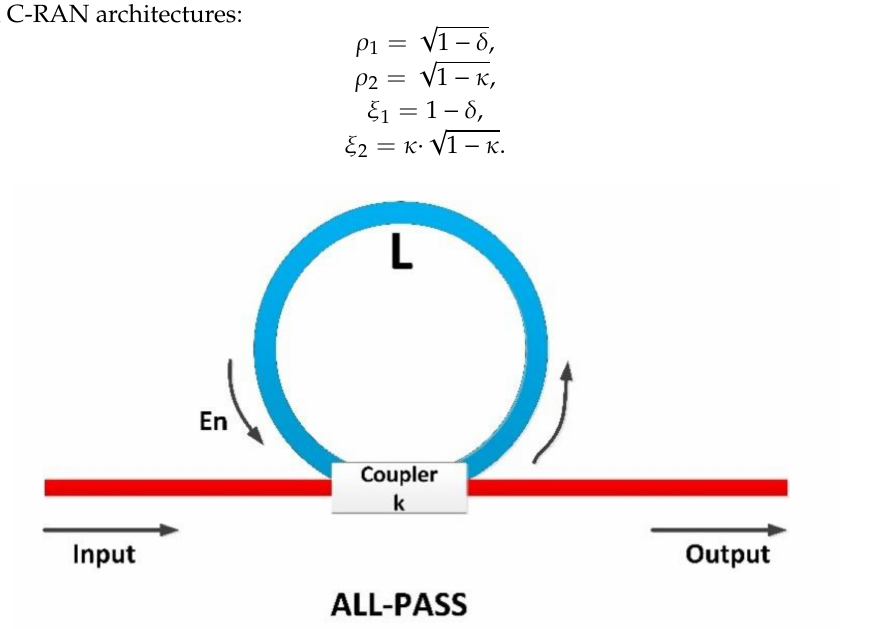
Figure 4. Cavity-like all-pass ring